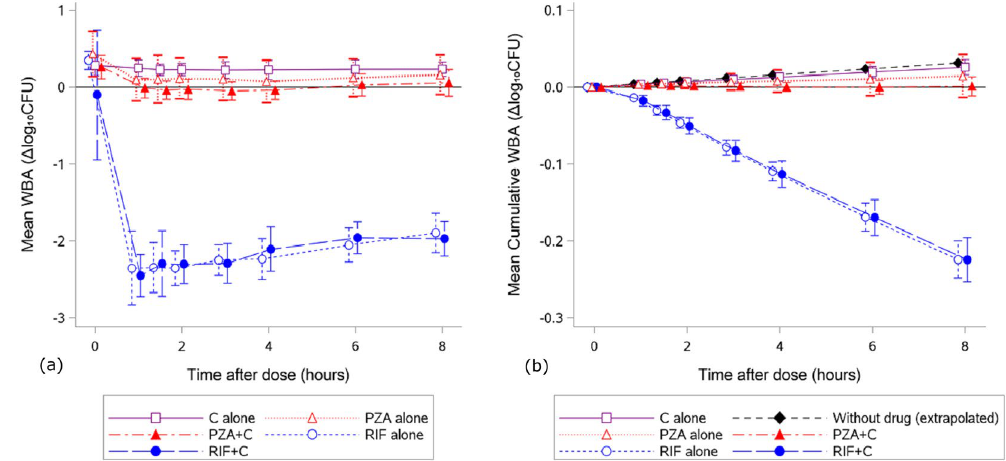
Figure 2. ( a ) Mean WBA at individual time-points up to 8 hours after dose. ( b ) Mean cumulative WBA at intervals up to 8 hours post-dose. The curve of “Without drug (extrapolated)” was obtained by assuming that the individual WBA values at 0 hour time-point (pre-dose) of celecoxib alone remain unchanged over a subsequent 8-hour interval. Abbreviations: C, celecoxib; RIF, rifampicin; PZA, pyrazinamide.